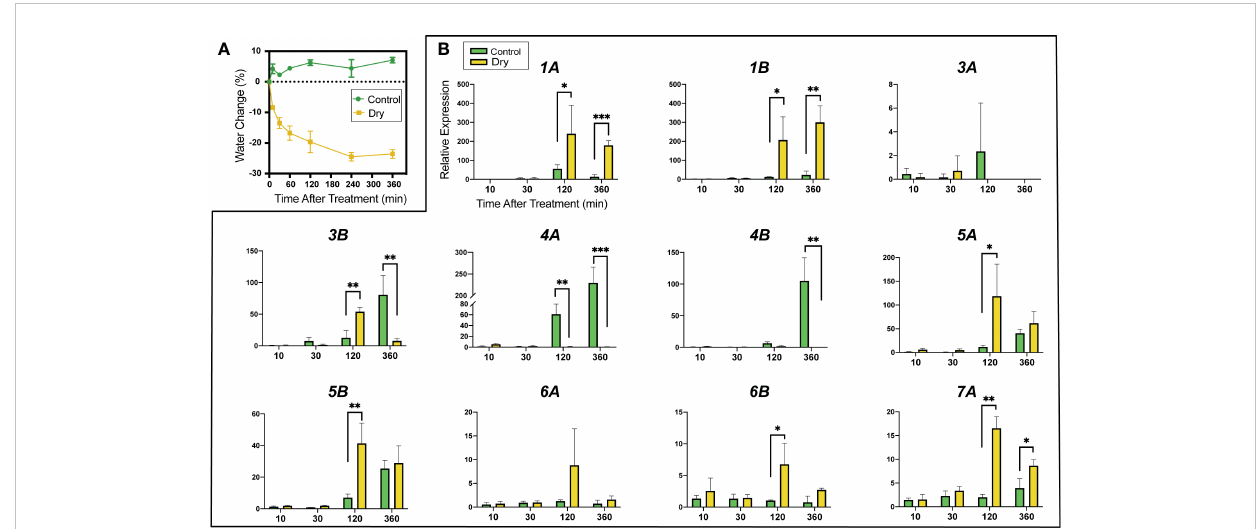
FIGURE 7 Expression of MdGA2ox genes in the leaf blade after leaf excision and induced water loss. The fi rst fully expanded leaf was excised from rapidly growing seedlings and either left on a bench to air dry or kept hydrated with the tip of petiole immersed in water. (A) . Changes of water content in the control (green line) and drying (yellow line) leaves. Leaf water change is de fi ned as the difference between the after-treatment weight and the initial weight. (B) . Relative gene expression in the control (green bar) and drying (yellow bar) leaves over time. Expression was analyzed at 10 min, 30 min, 120 min (2 h) and 360 min (6 h) after excision. Asterisks denote statistical signi fi cance (*, p < 0.05; **, p < 0.01, ***, p <